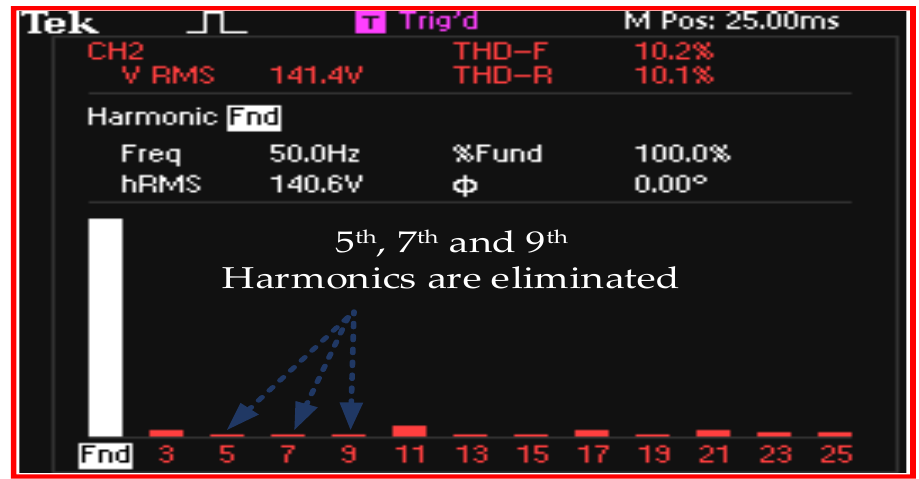
Figure 17. Voltage and current waveform at the R load.